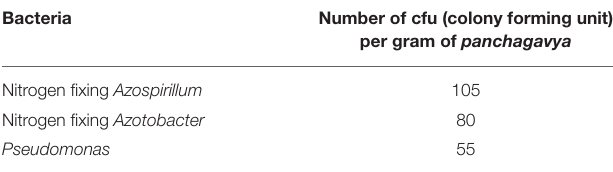
TABLE 2 | Biological properties of panchagavya . Bacteria Number of cfu (colony forming unit) per gram of